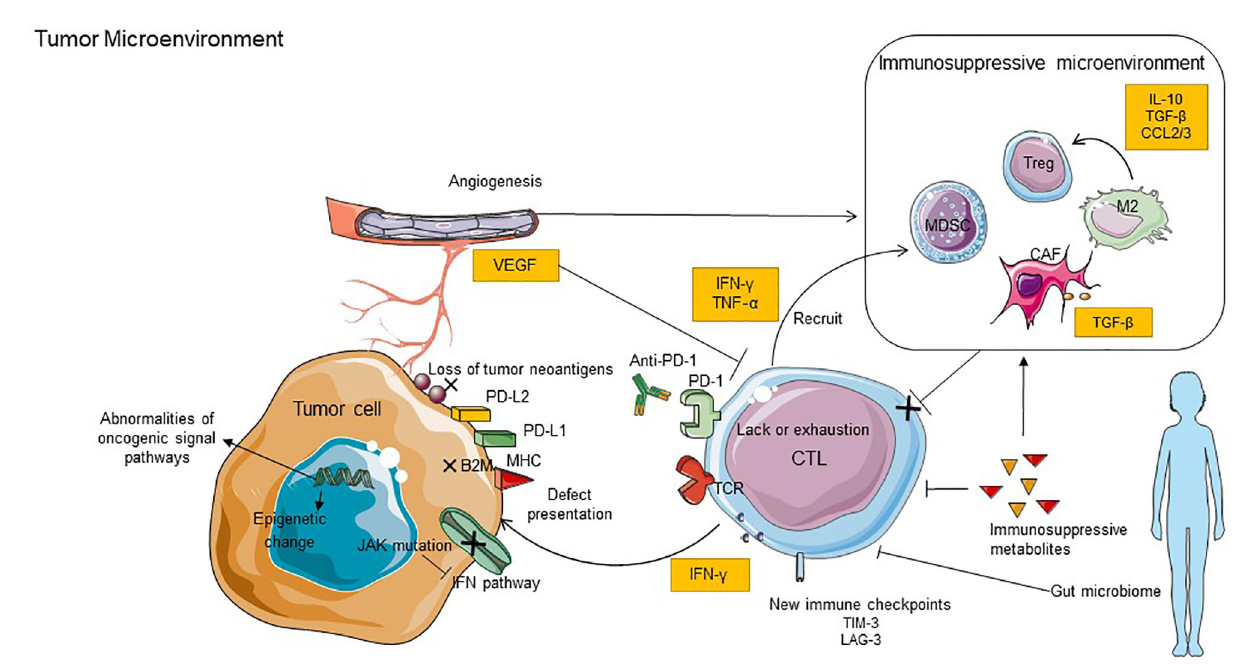
FIGURE 2 | Key mechanisms of resistance to anti-PD-1 inhibitors. The mechanisms of resistance including internal and external causes. The internal causes focus on the inherent characteristics of tumor cells, it includes defective tumor immunorecognition, epigenetic regulation, abnormal oncogenic signaling, and IFN- g signal pathway. The external causes are mainly emanated from the tumor microenvironment, such as exhaustion of T cells, immunosuppressive cells and cytokines, tumor metabolites, new immune checkpoints, and intestinal micro fl ora. B2M, B2-microglobulin; LAG3, lymphocyte-activation gene 3; TIM3, T cell immunoglobulin and mucin domain-containing molecule 3; VEGF, vascular endothelial growth factor; JAK, Janus